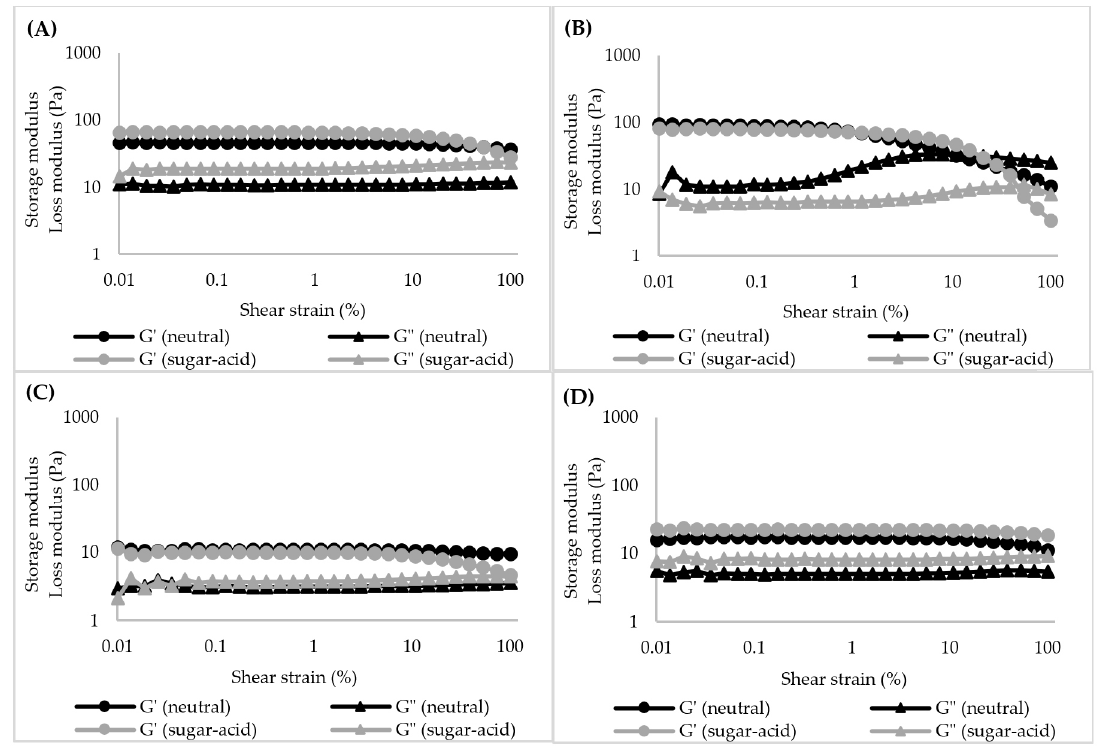
Figure 6 . Storage modulus (G ′ ) and loss modulus (G ″ ) of starch gels (6% w / v ) as a function of shear strain for the neutral system and sugar–acid system: ( A ): TS, ( B ): RS, ( C ): WTS, and ( D ): WRS.